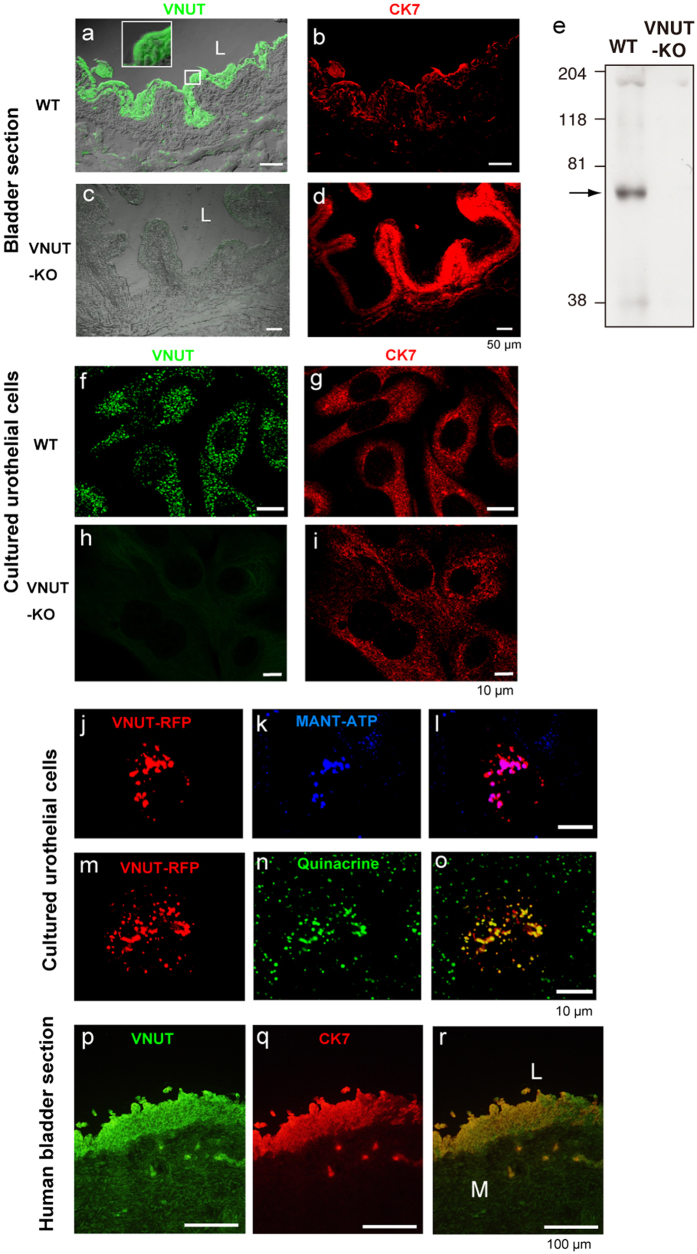
VNUT-positive signals in the bladder and cultured urothelial cells.(a–d) Immunohistochemical analysis of VNUT ((a,c) in green) and CK7 (b,d), in red) in mouse whole bladder tissue merged with a phase-contrast image. Images (a,b) show tissue from WT mice, while (c,d) show tissue from VNUT-KO mice. The magnified inset in (a) shows VNUT localization in each urothelial cell layer. L, lumen; scale bars, 50 μm. (e) Western blot of VNUT-positive signals in the bladder. The membranes of bladder (50 μg) prepared from WT and VNUT-KO mice were analysed by western blot with anti-VNUT-antibody. VNUT-positive signal (arrow) was not detected in the bladder obtained from VNUT-KO mice. (f–i) Immunocytochemical analysis of VNUT (f,h), in green) and CK7 (g,i), in red) in cultured urothelial cells. Images (f,g) show urothelial cells obtained from WT mice, while (h,i) show cells from VNUT-KO mice. Scale bars, 10 μm. (j–l) Co-localization of VNUT-RFP with MANT-ATP in mouse primary urothelial cells. Cultured urothelial cells were transfected with VNUT-RFP, followed by staining with MANT-ATP, a fluorescent ATP. (j) Labelling of urothelial cells with VNUT-RFP (red). (k) Urothelial cells incubated with MNAT-ATP (blue). (l) Merged image, showing VNUT-RFP localized with vesicles where MANT-ATP accumulated. (m–o) Co-localization of VNUT-RFP with quinacrine. Urothelial cells were transfected with VNUT-RFP followed by staining with quinacrine. (m) Labelling of urothelial cells with VNUT-RFP (red). (n) Labelling of urothelial cells with quinacrine (green). (o) Merged image showing VNUT-RFP co-localised with quinacrine-positive signals. Scale bars, 10 μm. (p–r) Immunohistochemical analyses of the human bladder. (p) VNUT-positive staining (green) was localized in each urothelial cell layer. (q) Urothelial marker CK7-positive staining (red) in human bladder tissue. (r) Merged image of (p,q). Scale bars, 100 μm.